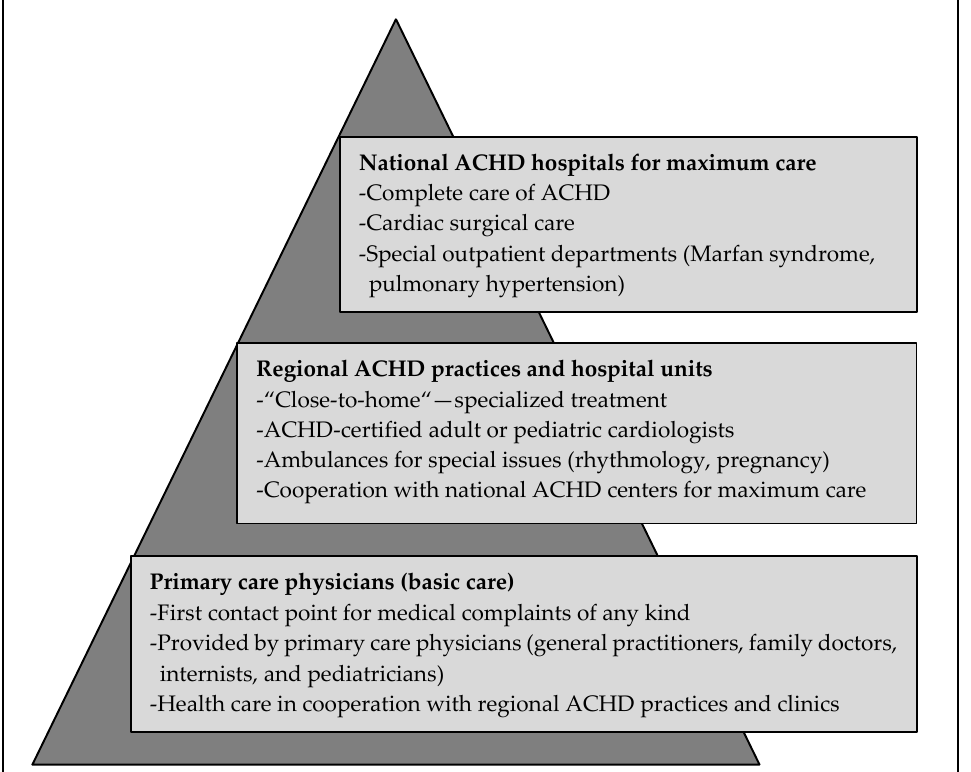
Figure 1. Pyramid of adult congenital heart disease (ACHD) care (modified according to [18]). The